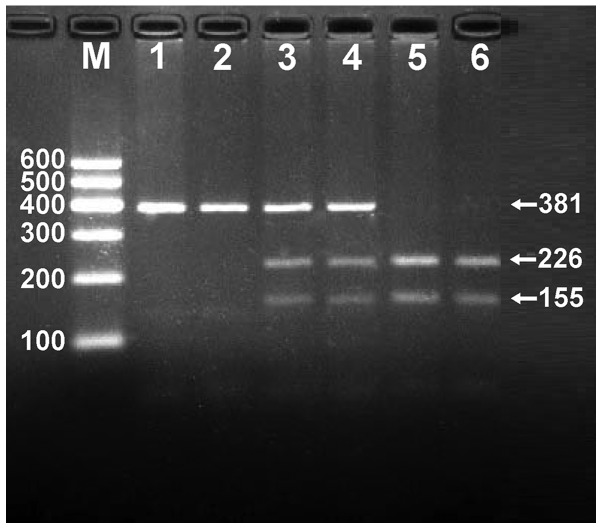
Genotyping of the PABPC4 rs4660293 single nucleotide polymorphism. Lanes: M, 100 bp marker ladder; 1 and 2, AA genotype (381 bp); 3 and 4, AG genotype (381, 226 and 155 bp); 5 and 6, GG genotype (226 and 155 bp).